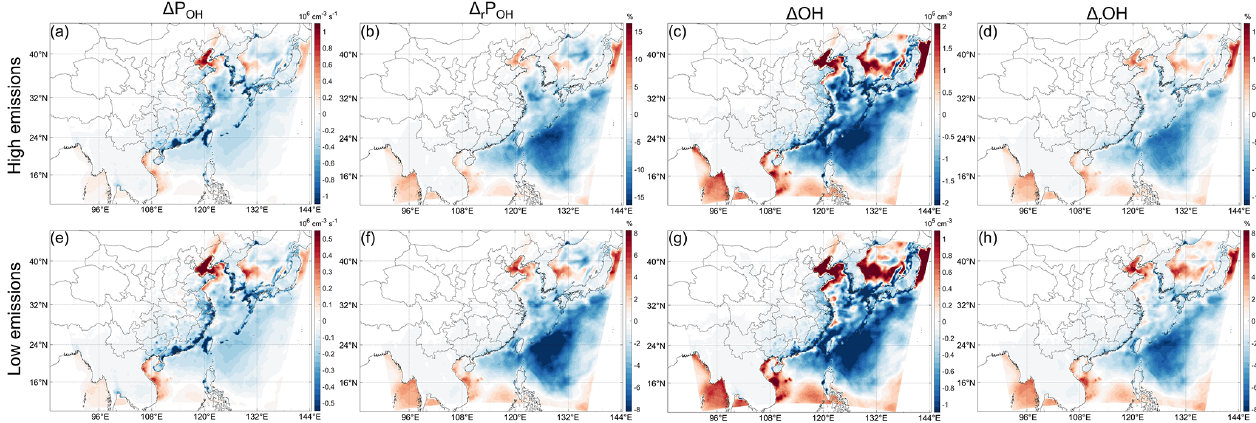
Figure 2. Change or relative change compared to the BASE case in monthly averaged surface-layer P OH and OH in All_high case (first row) and All_low case (second row). The subscript r denotes “relative”. Note the different scales in the All_high and All_low cases; the latter is exactly half of the